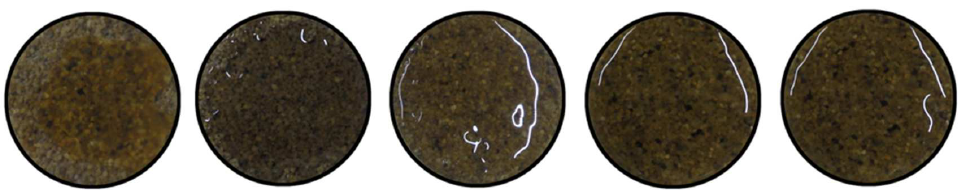
Figure 9. Example of snapshots of the window of coarse sand specimens once the test stopped with no fractures being induced in coarse bio-cemented sands across various cementation levels.